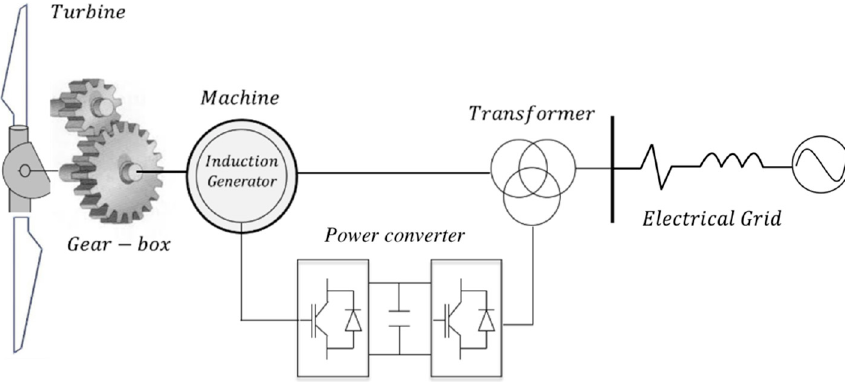
Figure 1. Configuration of a DFIG connected to the electrical grid.